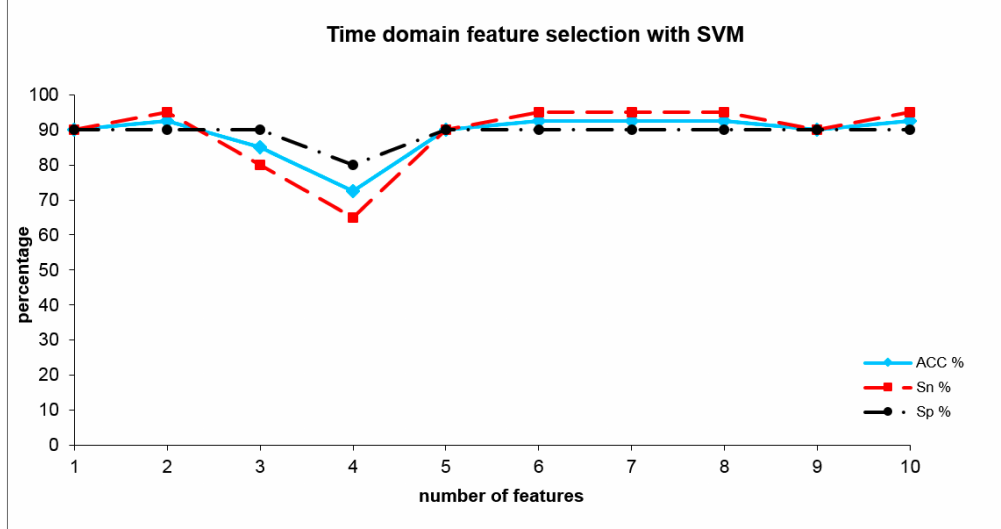
Figure 5. Accuracy, sensitivity and specificity using SVM analysis from time domain indices where the group cannabis use- was discriminated from the group tobacco smokers group, dependent upon the number of included optimum